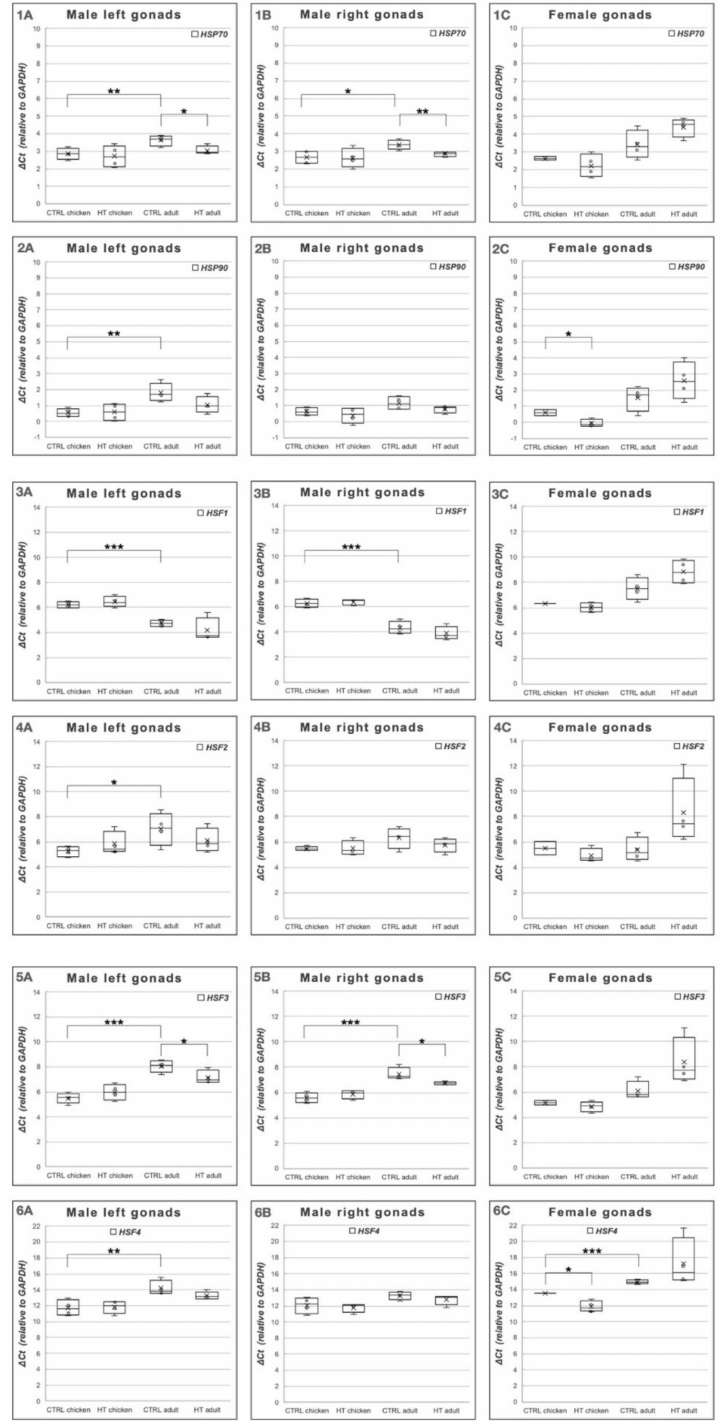
Figure 3. Delta Ct values of two heat-shock protein ( HSP70 and HSP90 ) and four heat-shock factor HSF1 , HSF2 , HSF3 , HSF4 ) genes were determined in male and female left gonads of (heat-treated) HT and (control) CTRL chicks and adults. In every case the GAPDH was the reference gene. ( 1 ): HSP70; ( 2 ): HSP90; ( 3 ): HSF1; ( 4 ): HSF2; ( 5 ): HSF3; ( 6 ): HSF4. ( A ): Male left gonads; ( B ): Male right gonads; ( C ): Female gonads. * p < 0.05, ** p < 0.01, *** p <